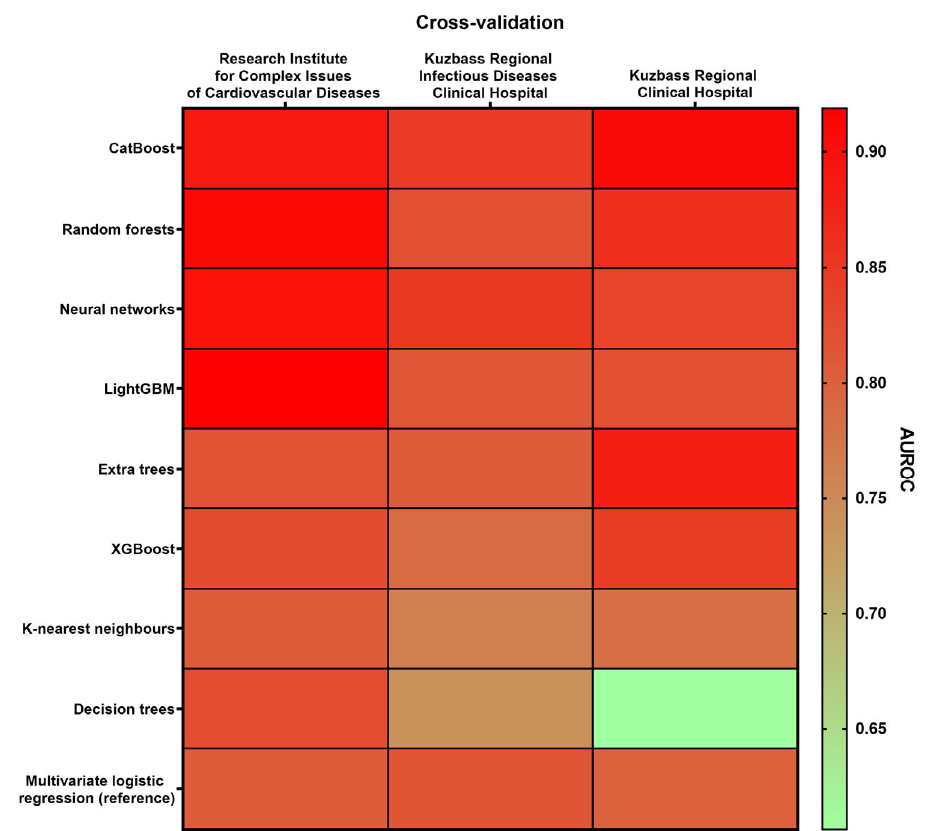
Figure 4. Heat map demonstrating the variability of AUROC in different combinations of learning and cross-validation samples. The color range from green to red indicates the ascending AUROC (the low- est and the highest AUROC are marked green and red, respectively). Left column: learning dataset: Kuzbass Regional Infectious Diseases Clinical Hospital and Kuzbass Regional Clinical Hospital ( n = 250), cross-validation dataset: Research Institute for Complex Issues of Cardiovascular Diseases ( n = 100). Central column: learning dataset: Research Institute for Complex Issues of Cardiovascular Dis- eases and Kuzbass Regional Clinical Hospital ( n = 244), cross-validation dataset: Kuzbass Regional Infectious Diseases Clinical Hospital ( n = 106). Right column: learning dataset: Research Institute for Complex Issues of Cardiovascular Diseases and Kuzbass Regional Infectious Diseases Clinical Hospi- tal ( n = 206), cross-validation dataset: Kuzbass Regional Clinical Hospital ( n = 144).